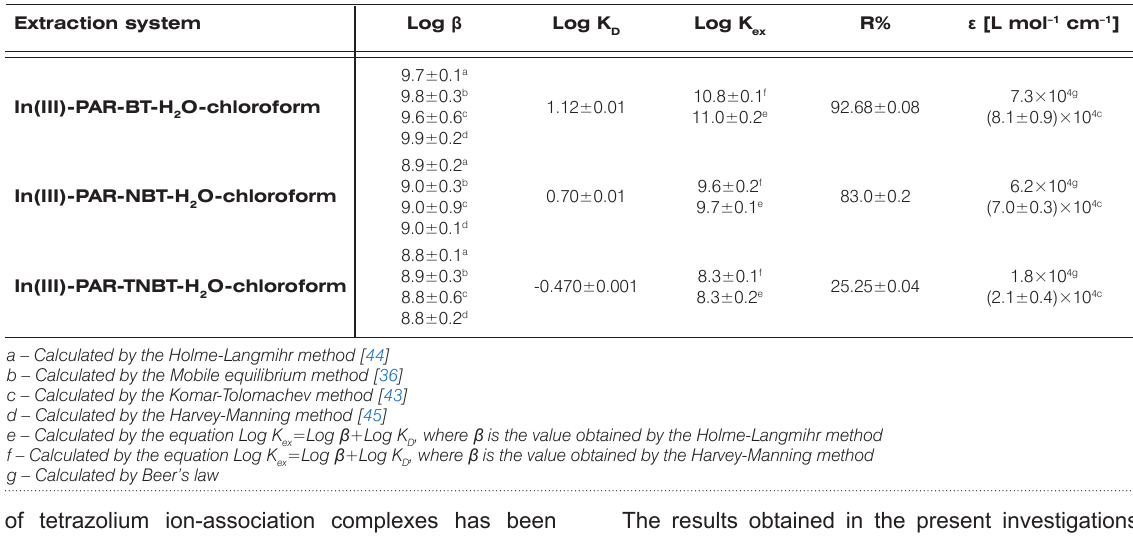
=2C , C =4.0 mol L –1 , pH=8.5 (lines 1 and 2) or 8.3 (line 3). Straight line equations: MBT In(III) PAR ), distribution constants (K ), association constants ( β ), recovery factors (R%) ex D